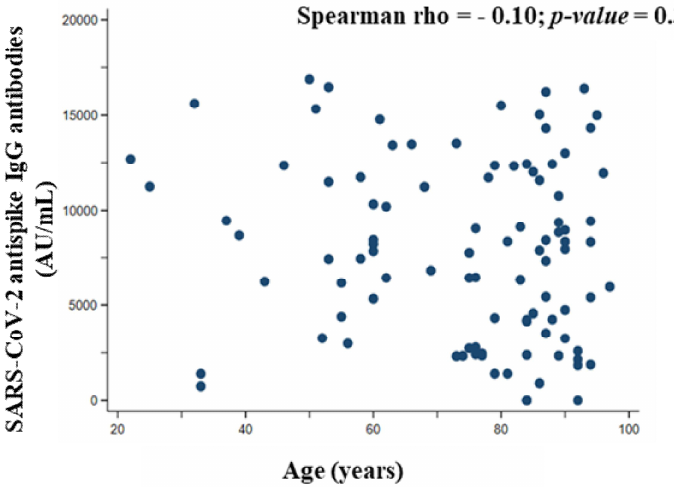
Figure 4. Correlation between total SARS-CoV-2 anti-spike IgG antibody titer (AU/mL) quantified 20 days after administration of the second dose of vaccine and age of participants.